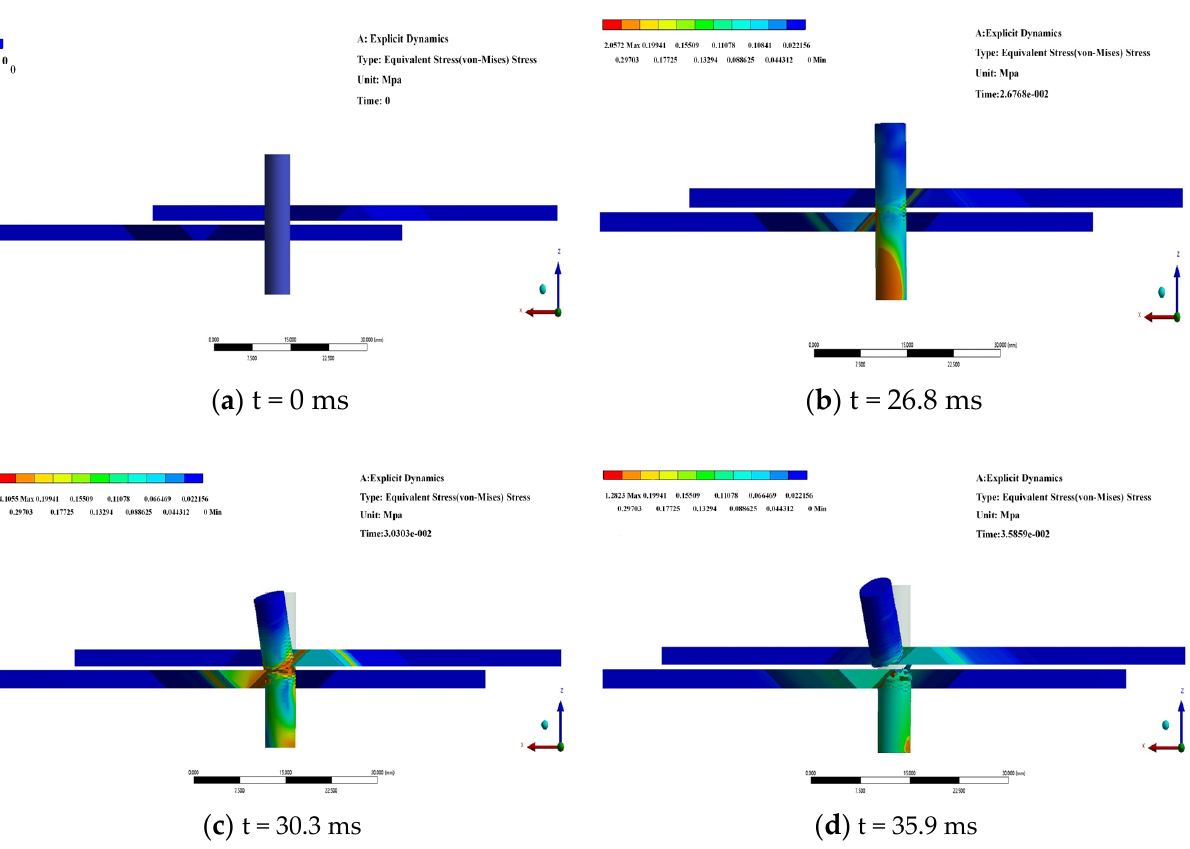
Figure 8. The effective stress cloud diagram of cutting unit.